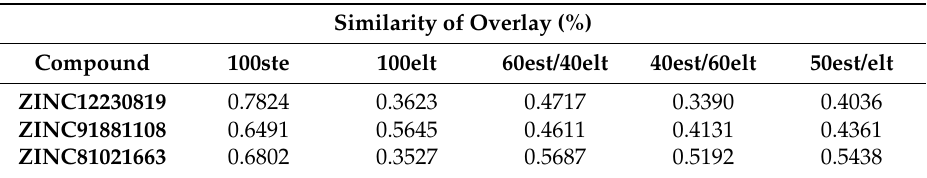
Table 6. Similarity analyses for the molecular overlap of the compounds for 100ste, 100elt, 60est and 40elt, 50est/elt, relative to